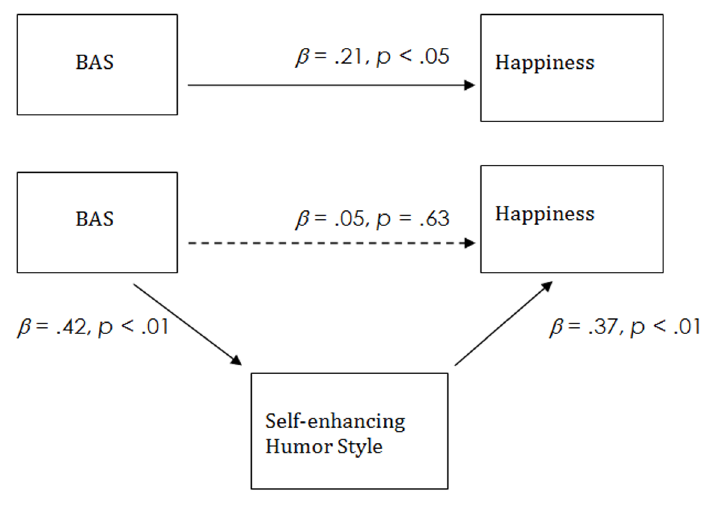
Figure 1. The relation between BAS, self-enhancing humor style and